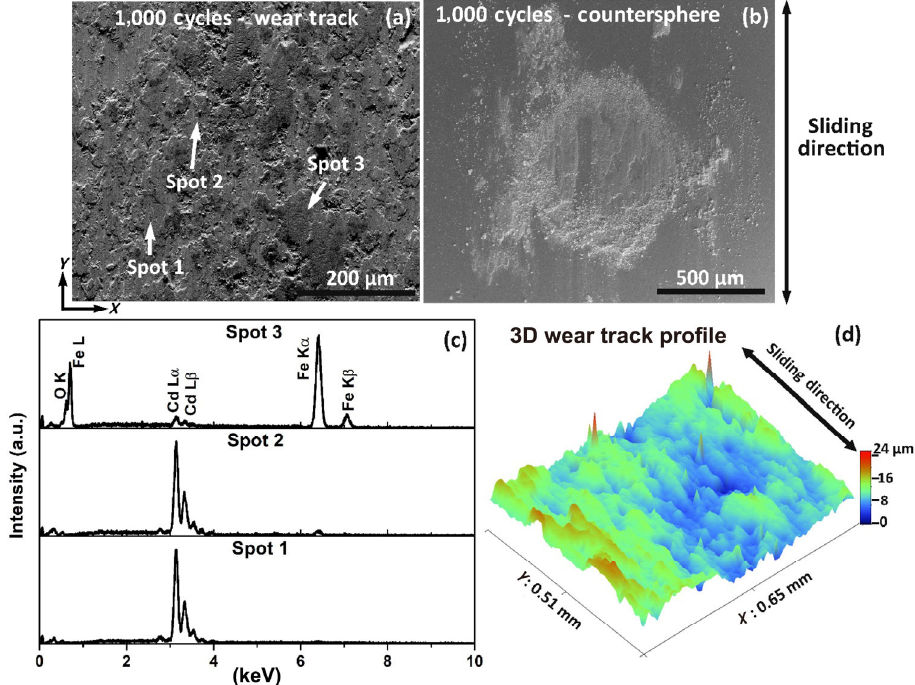
Fig. 8 (a) Wear track morphology with predominant steel substrate, (b) countersphere SEM image with scar mark, (c) EDS analysis of wear track, and (d) 3D surface profile of wear track showing presence of Fe at elevated regions at 1,000